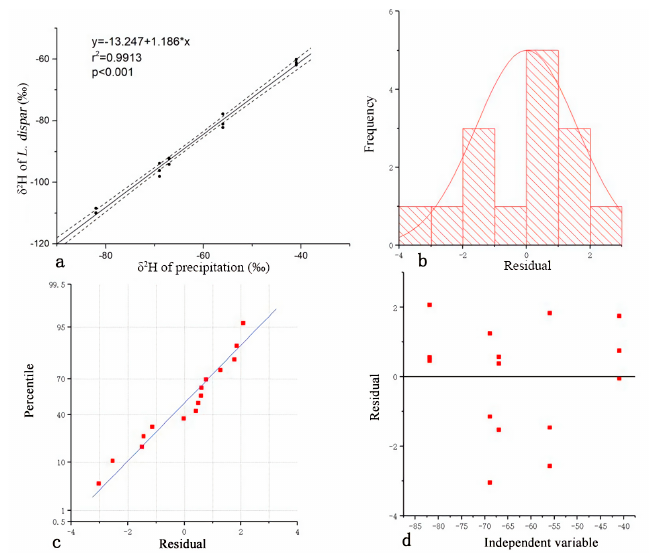
Figure 2. Results of L. dispar model testing by Origin software. ( a ) The standard curve equation describing the relationship between L. dispar and precipitation based on δ 2 H value (the solid line indicates linear regression; the dotted line represents the 95% confidence interval); ( b ) Data residual histogram with a normal curve; ( c ) Normal probability plot; ( d ) Independent variable residual plot.